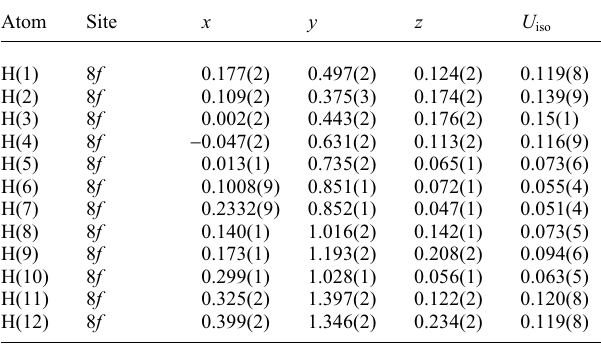
Table 2. Atomic coordinates and displacement parameters (in Å 2 )